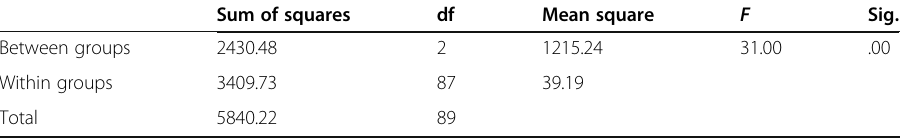
Table 6 Results of one-way ANOVA for comparing the speaking fluency post-test scores of the GDA, C-DA, and N-DA learners Sum of squares df Mean square F Sig. Between groups 2430.48